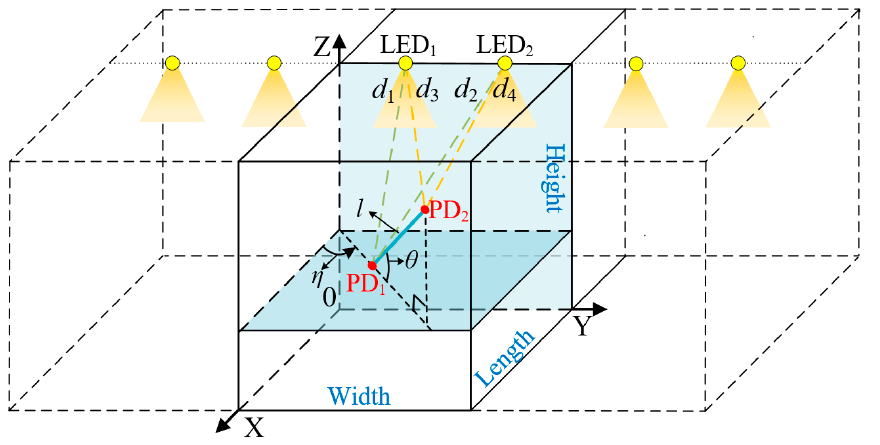
Figure 1. Proposed VLPO system.